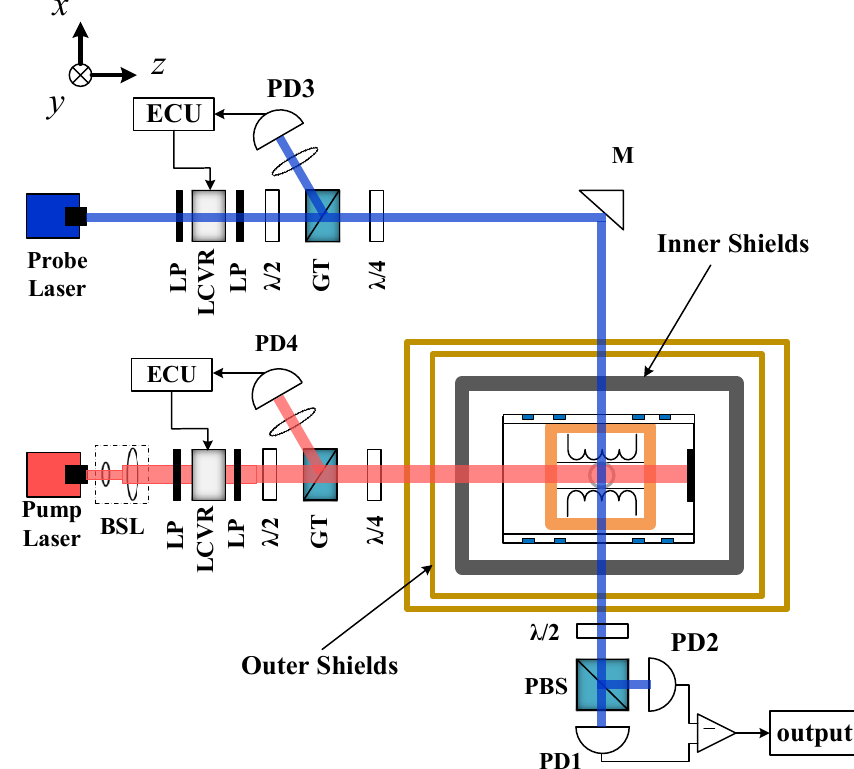
Figure 1. Schematic of K-Rb- 21 Ne co-magnetometer. BSL: beam shaping lenses. LP: linear polarizer. LCVR: liquid crystal variable retarder. λ /2: half wave plate. GT: Glan–Taylor polarizer. λ /4: quarter wave plate. PBS: polarizing beam splitter. M: reflection mirror. PD: photodiode. ECU: electronic control unit. The magnetic shield system of common magnetic force consists of three shield layers. The outer shield consists of two 2 mm thick µ -metal shields with outer radii of 54 mm and 64 mm and lengths of 150 mm and 180 mm, respectively. The inner shield is the focus of our